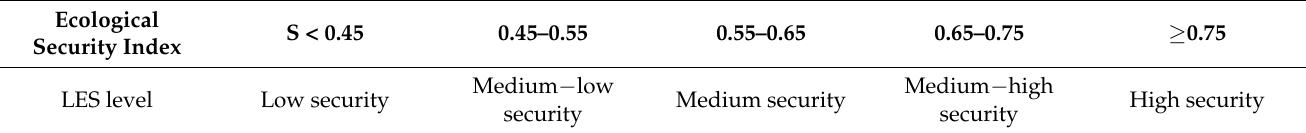
Table 4. Evaluation level of LES. S represents the ecological security index. LES represents land ecological